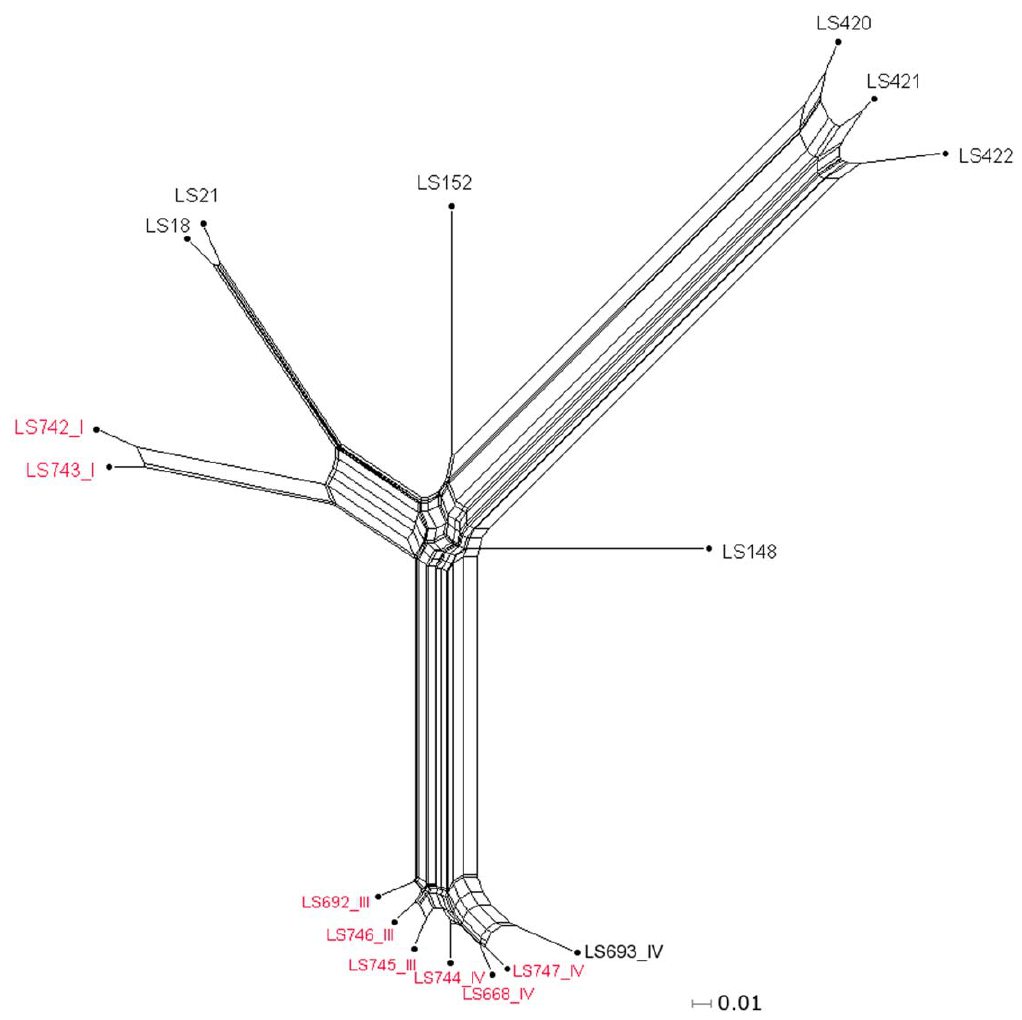
Figure 4. Relatedness analysis of the compatible parsimony informative genes from the 9 cantaloupe associated outbreak isolates, a shrimp isolate (LS693) and 7 unrelated L.monocytogenes isolates belonging to serotype 1/2a [ 28 ] . The tree was generated from the concatenated gene contents using neighbor joining with the uncorrected p distance. The numbers highlighted in red indicate the cantaloupe associated outbreak and the shrimp isolates. Scale bar represents number of gene differences (present or absent) per gene site. The Roman numerals represent the PFGE pattern combination.